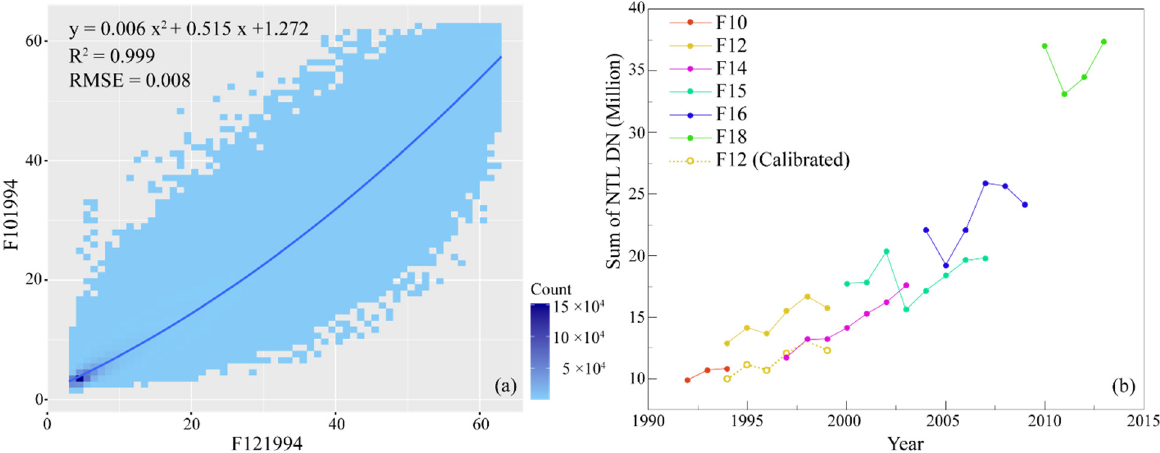
Figure 3. ( a ) The fitting parameters of the systematic calibration model of F12 and ( b ) the variation trend of the total DN value of calibrated lit